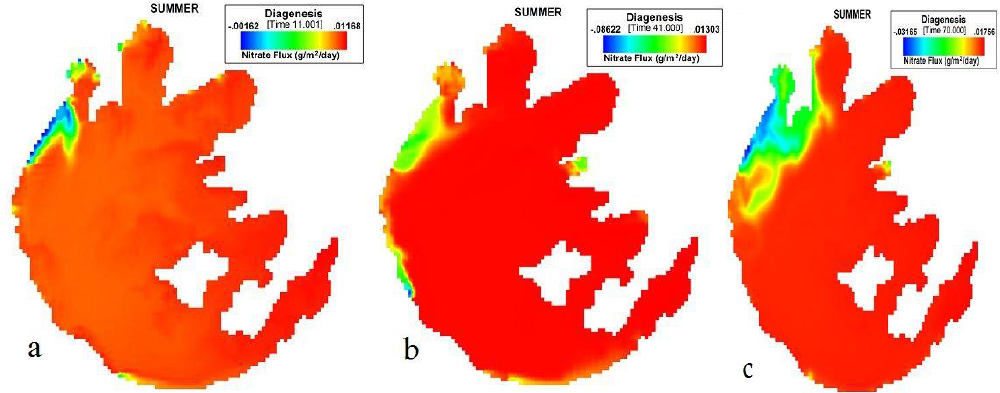
Figure 2. (a) 11 th , (b) 41 st , (c) 70 th day simulation of NO 3 flux variation during summer at Taihu. Figure 2. ( a ) 11th, ( b ) 41st, ( c ) 70th day simulation of NO 3 flux variation during summer at